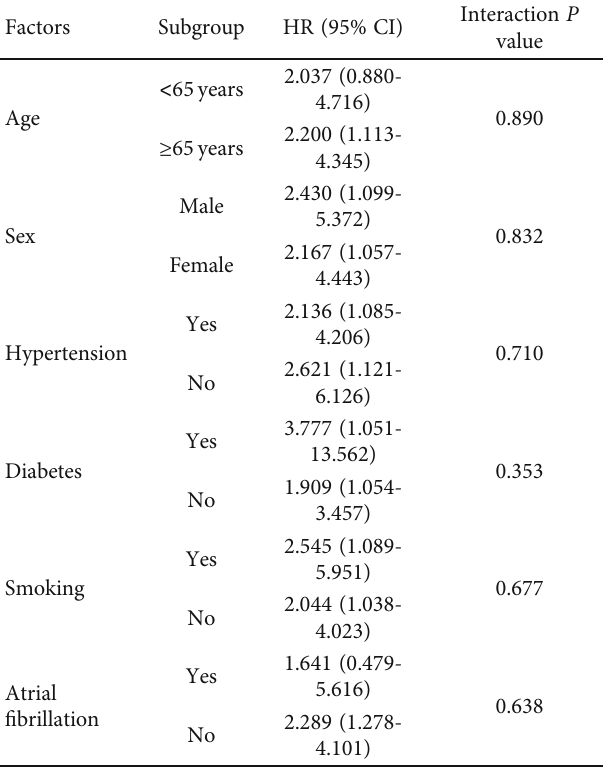
Table 5: Subgroup analysis of the association between high NPR and